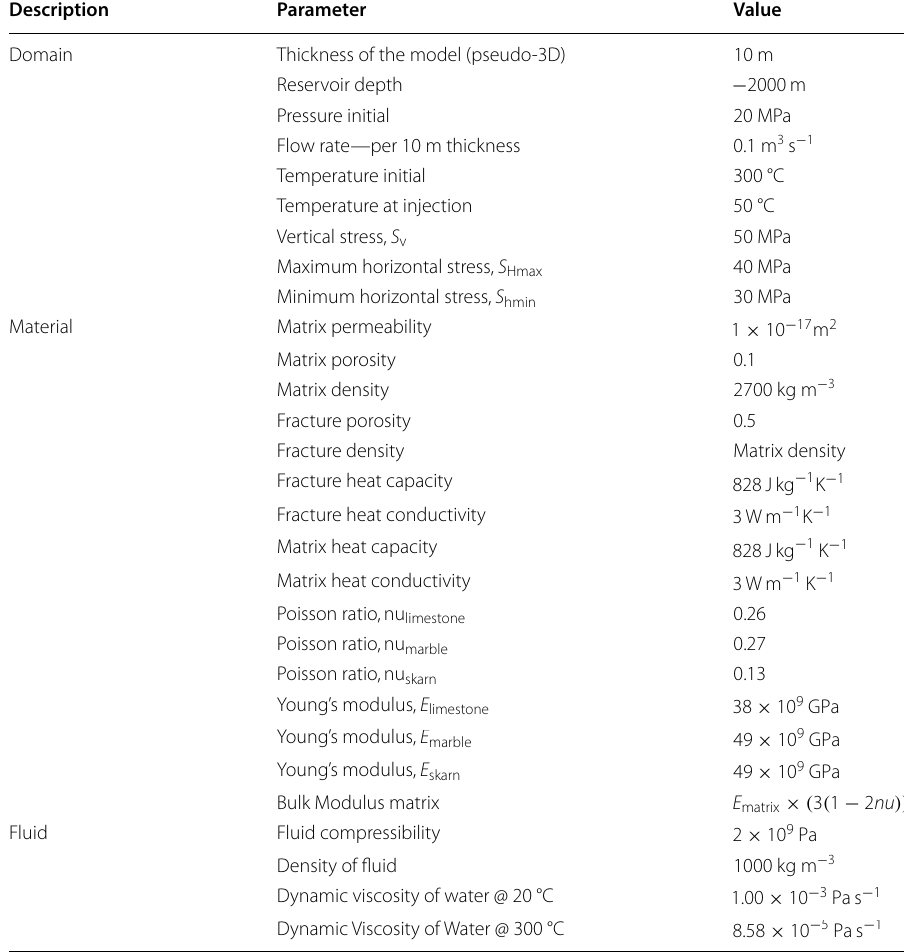
Table 3 Input parameters for simulation